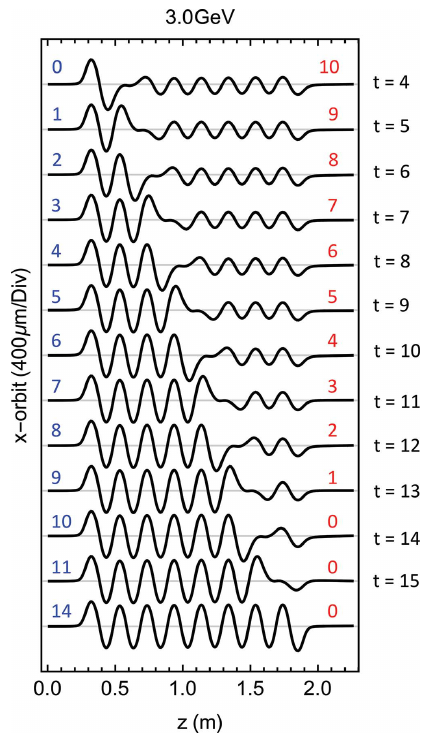
Figure 10 The orbit in the modulator for several possible arrangement of the K A K B configuration, starting from the bottom with only K A . In blue is the number of resonant poles at K A and in red that at K B .